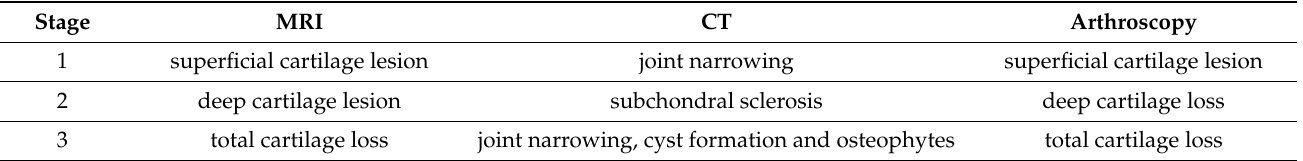
Table 1. Classification of cartilage lesions in the scaphoid